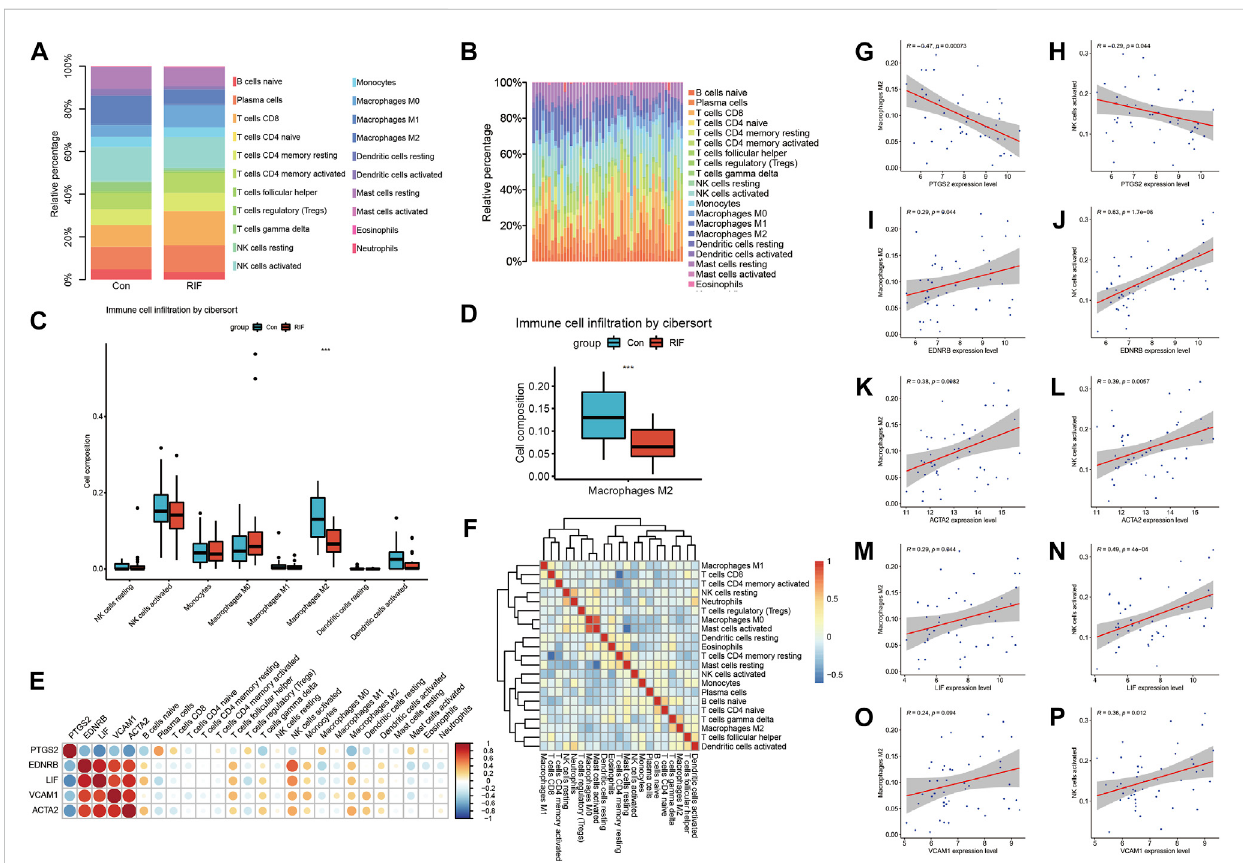
FIGURE 5 The immune in fi ltration analysis. (A, B) Immune in fi ltration analysis for 21 types of immune cell composition of endometrial tissue from RIF versues control group. (C) Box plot reveals the composition of eight types of immune cells in RIF and control group. (D) Box plot refers to the amount of M2 macrophagesin RIF and control group. (E) Heat map exhibit the association of hub genes betweenhub genes and hub genes between immune cells. (F) Heat map reveals the relation of immune cells enriched. (G,I,K,M,O) Correlation scatter plots between expression of PTGS2/EDNRB/ACTA2/LIF/ VCAM1 and Macrophages M2. (H,J,L,N,P) Correlation scatter plots between expression of PTGS2/EDNRB/ACTA2/LIF/VCAM1 and NK cells